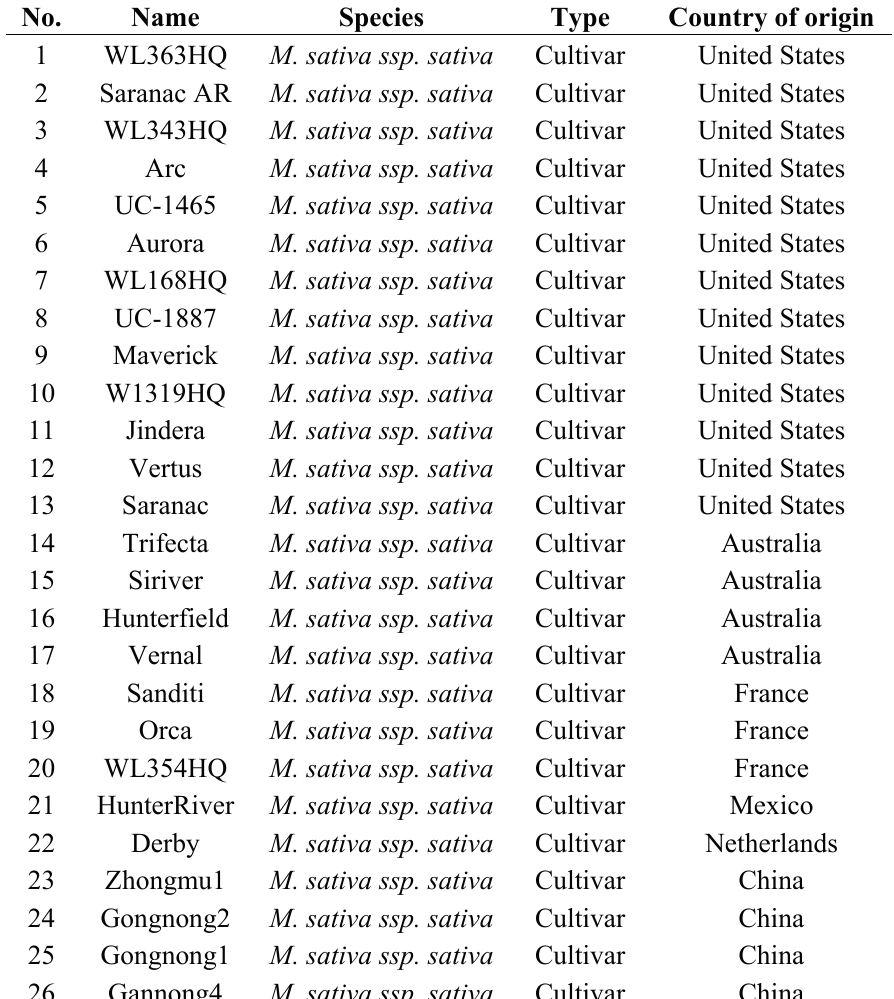
Table 3. List of 44 alfalfa accessions used for genetic diversity analysis in this study.